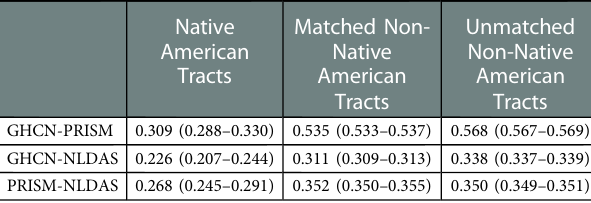
TABLE 3 Sociogeographically-Matched analysis of native American